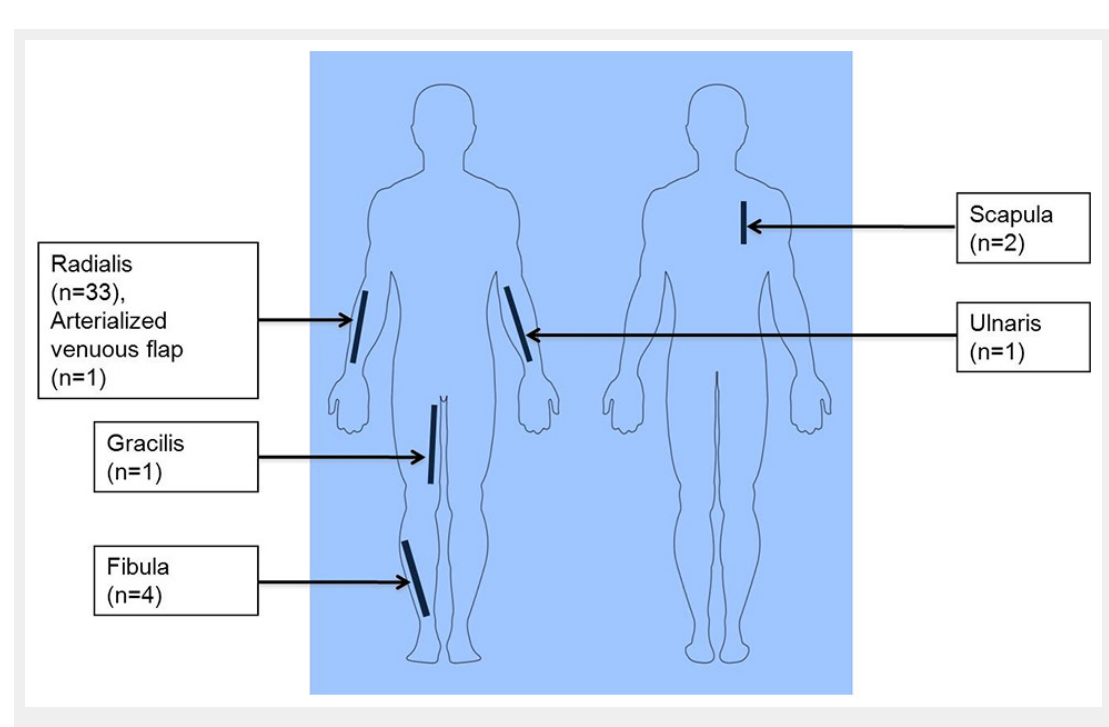
Figure 1 Distribution of flap donor sites in all reviewed patients undergoing microvascular free tissue